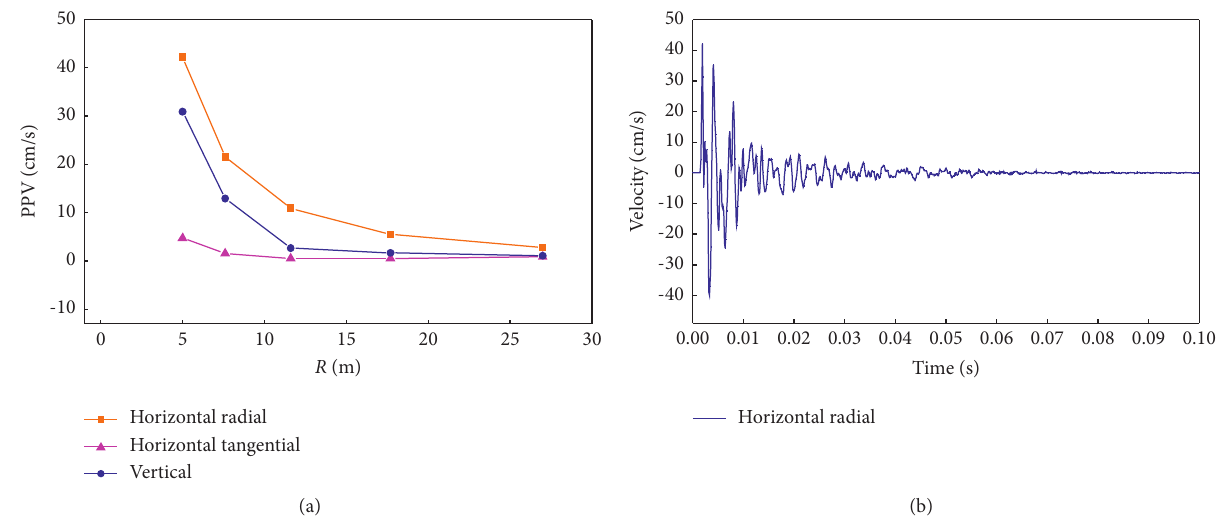
Figure 4: Single-hole blasting vibration. (a) PPV. (b) Waveform.